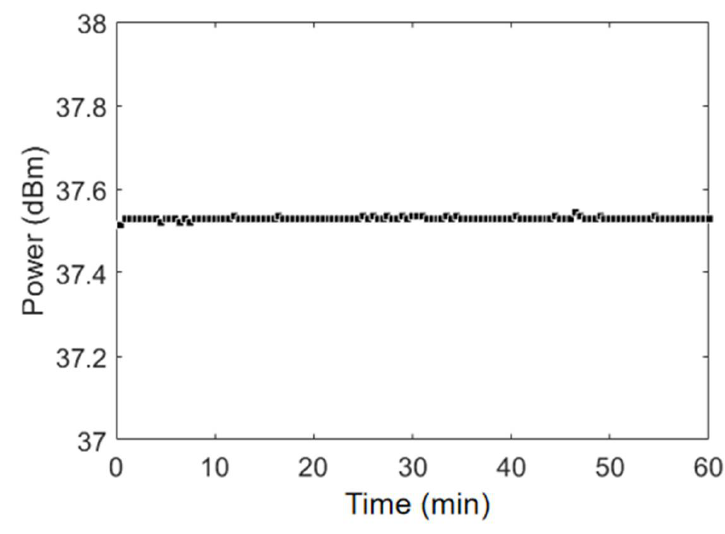
Figure 5. The spectrogram of the MOPA system.